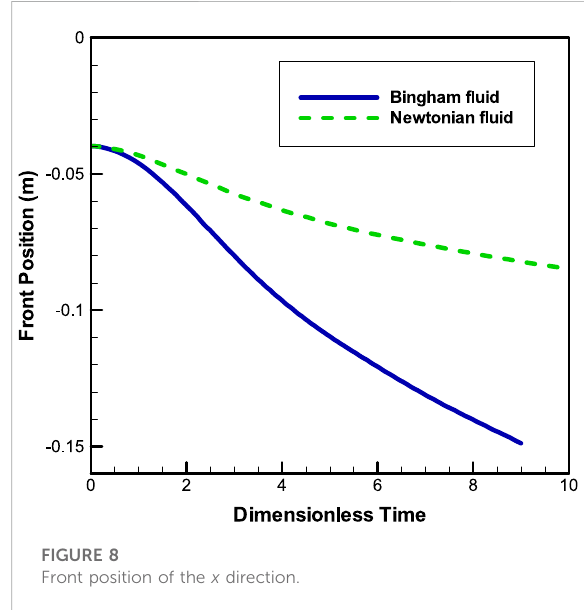
FIGURE 7 Front average velocity.